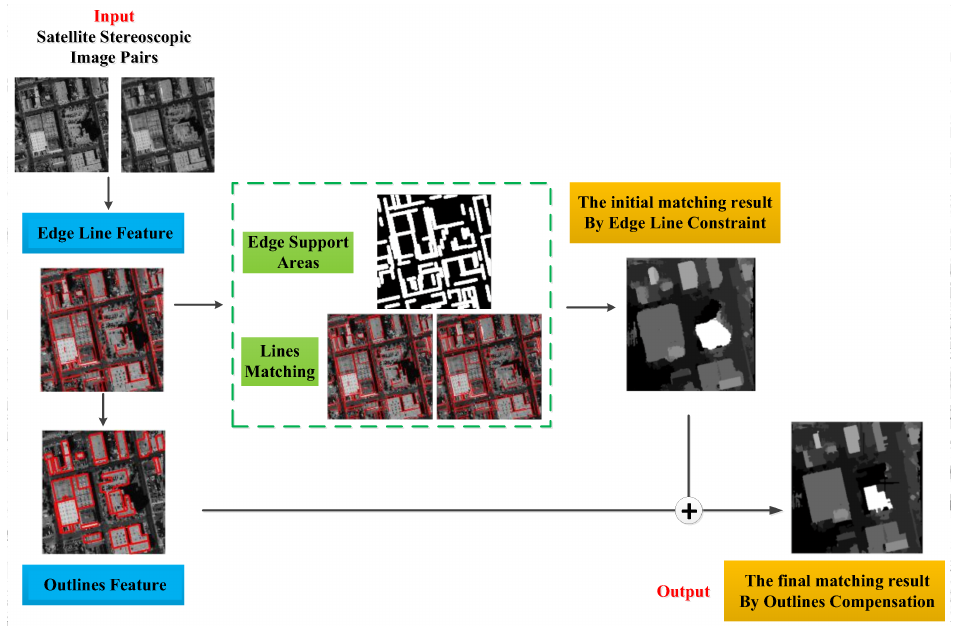
Figure 1. The whole flow chat of the